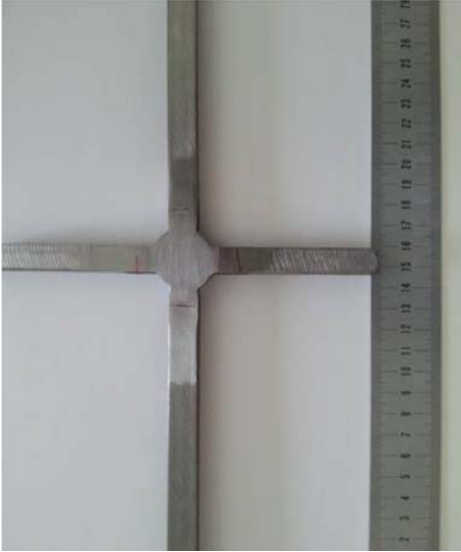
Figure 1: Cruciform welded joint. Figure 2: Specimen